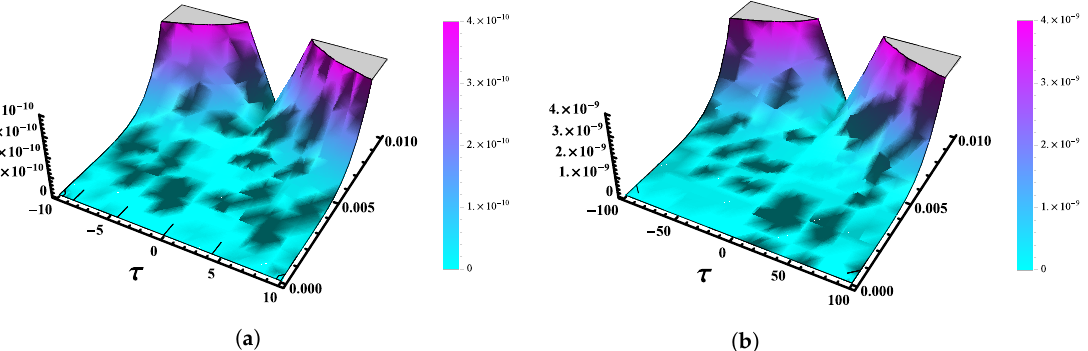
Figure 15. Absolute Error (AE) 3D graph of the obtained numerical solutions by using FNAM verses